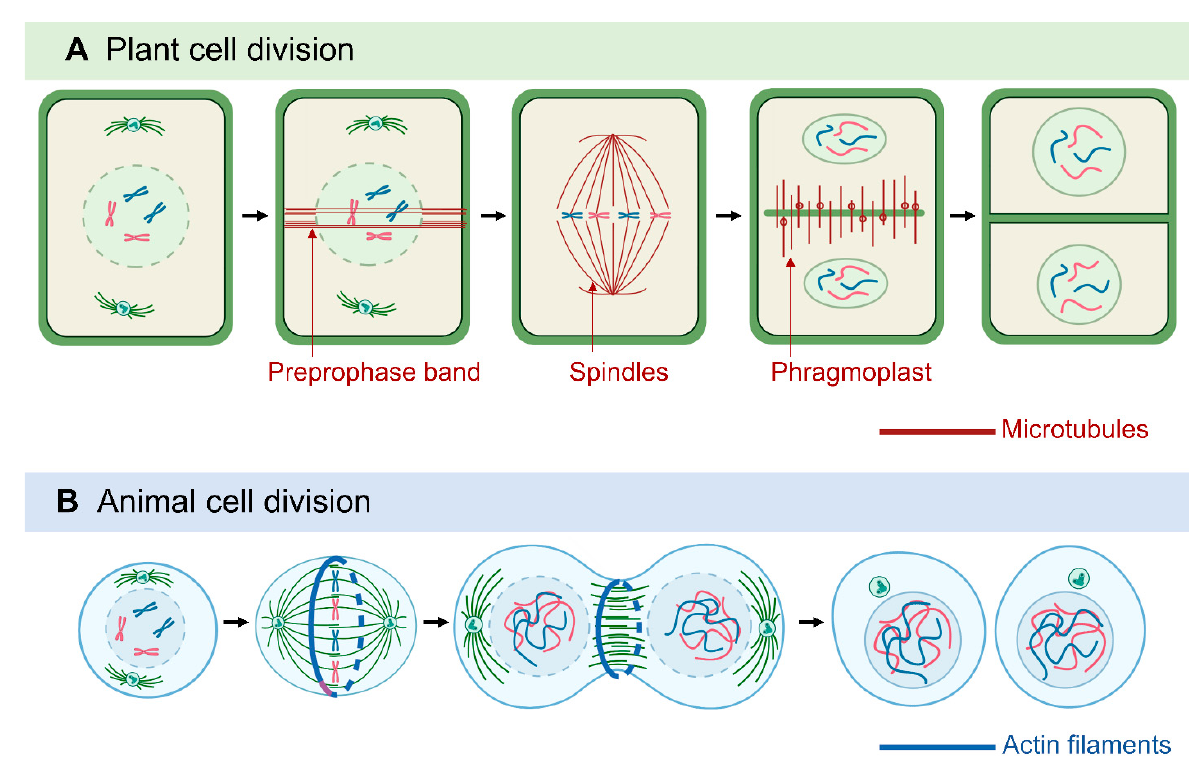
Figure 1. Comparison of plant and animal cell division. Plant cell division ( A ) is characterized by microtubule (MT)-based structures: the preprophase band, the acentrosomal mitotic spindle, and the phragmoplast. In animal cell cytokinesis ( B ), the contractile ring pinches the cell into two daughter cells, whereas plant phragmoplasts extend and guide vesicle fusion to generate the cell plate. Another plant-specific MT machinery, the phragmoplast, is formed between the re- constituting daughter nuclei at the end of telophase, as a hallmark of cytokinesis [70]. The